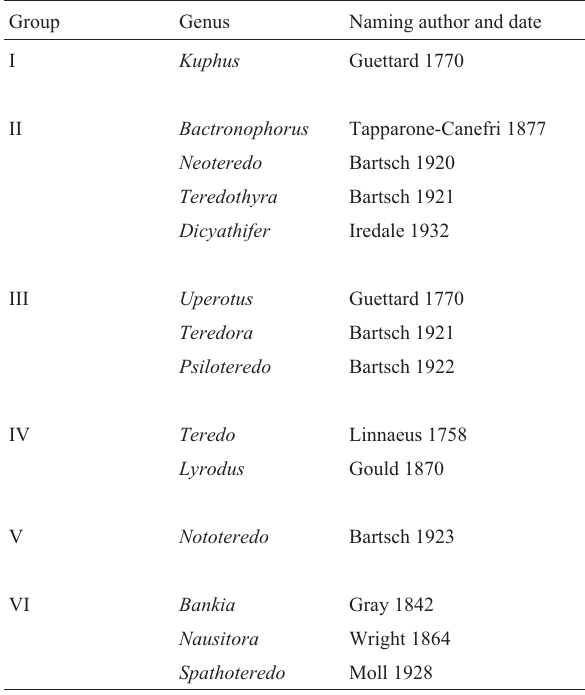
Table 1 - Teredinidae as grouped by Turner (1966).